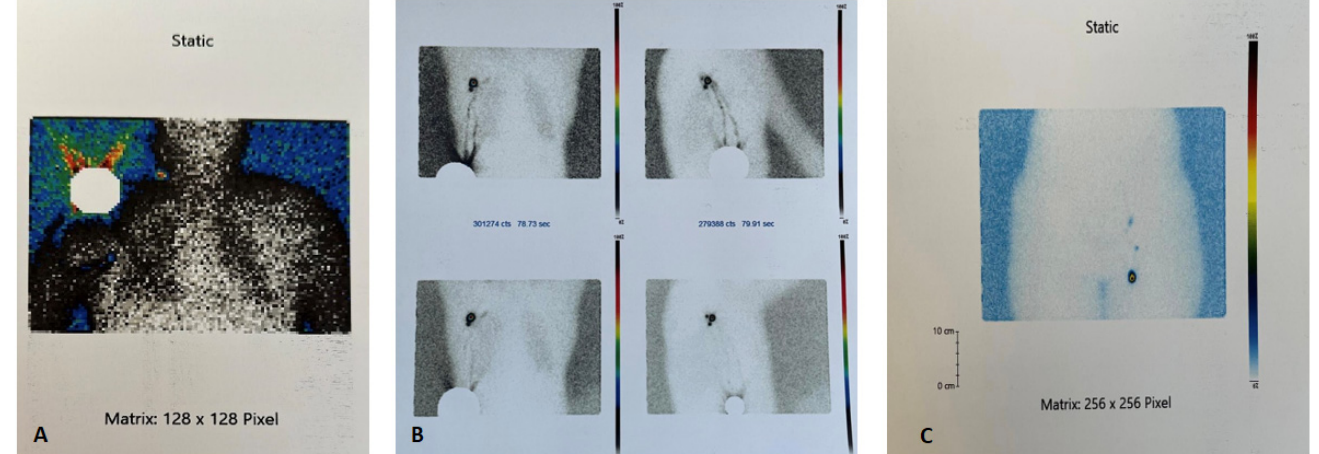
Figure 2. Lymphoscintigraphy aspect—Dr. Leventer Centre Collection. ( A ). Radiotracer capture on melanoma site (right shoulder). ( B ). Axillary sentinel lymph node. ( C ). Femoral sentinel lymph node.